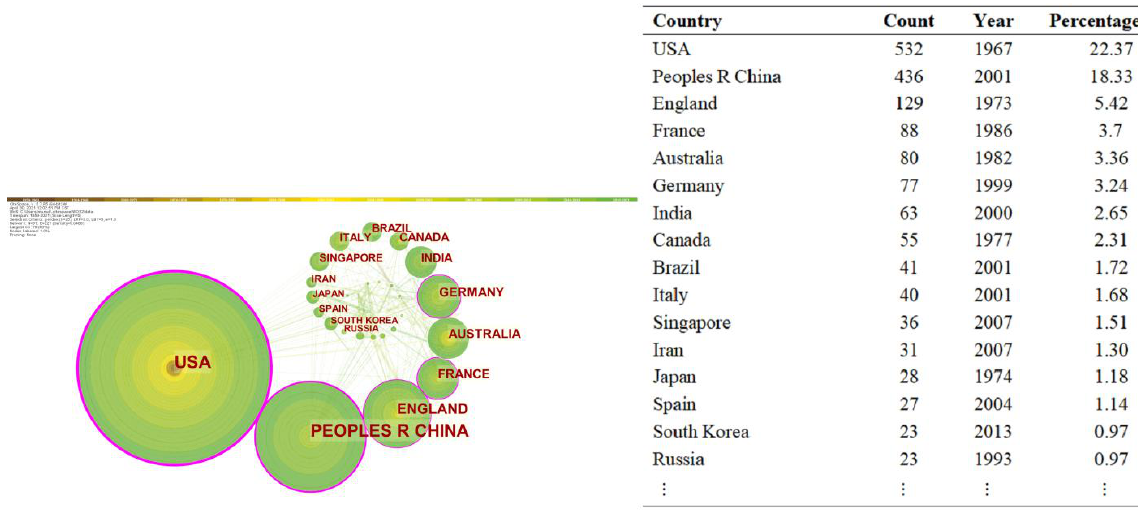
Figure 3. Rumors research distribution in different countries.